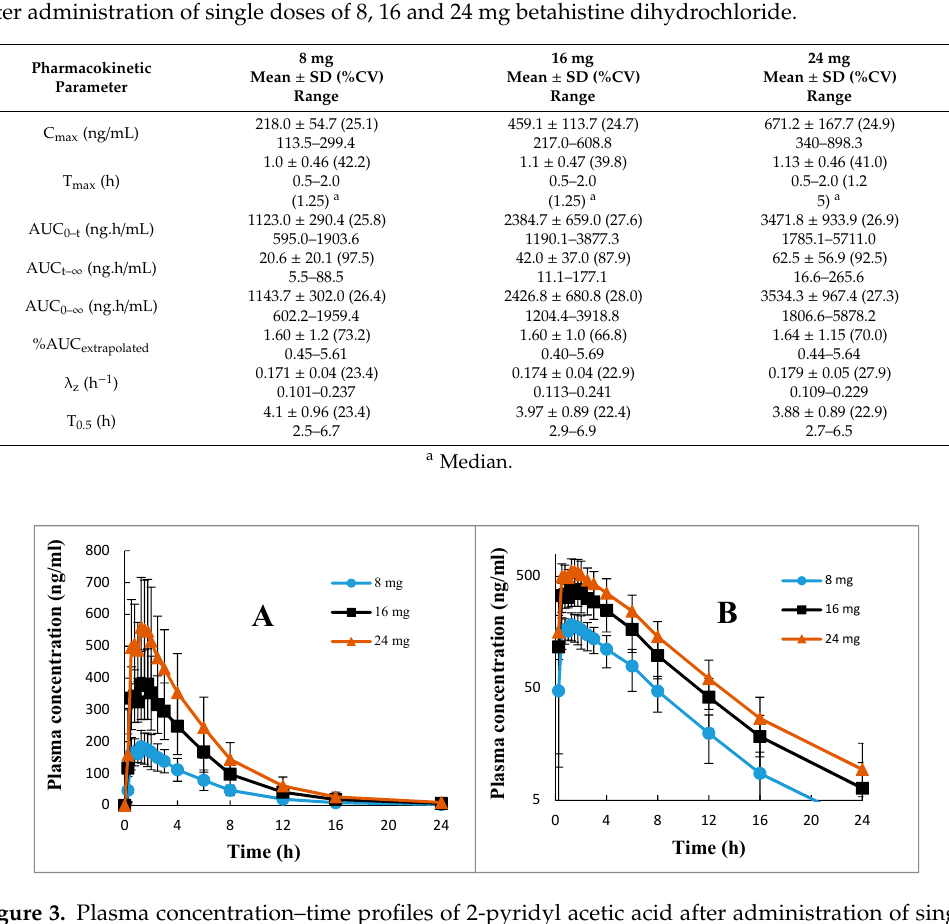
Figure 3. Plasma concentration–time profiles of 2-pyridyl acetic acid after administration of single doses of 8, 16, and 24 mg betahistine, mean ± SD, ( A ) normal scale, ( B ) semilog scale .